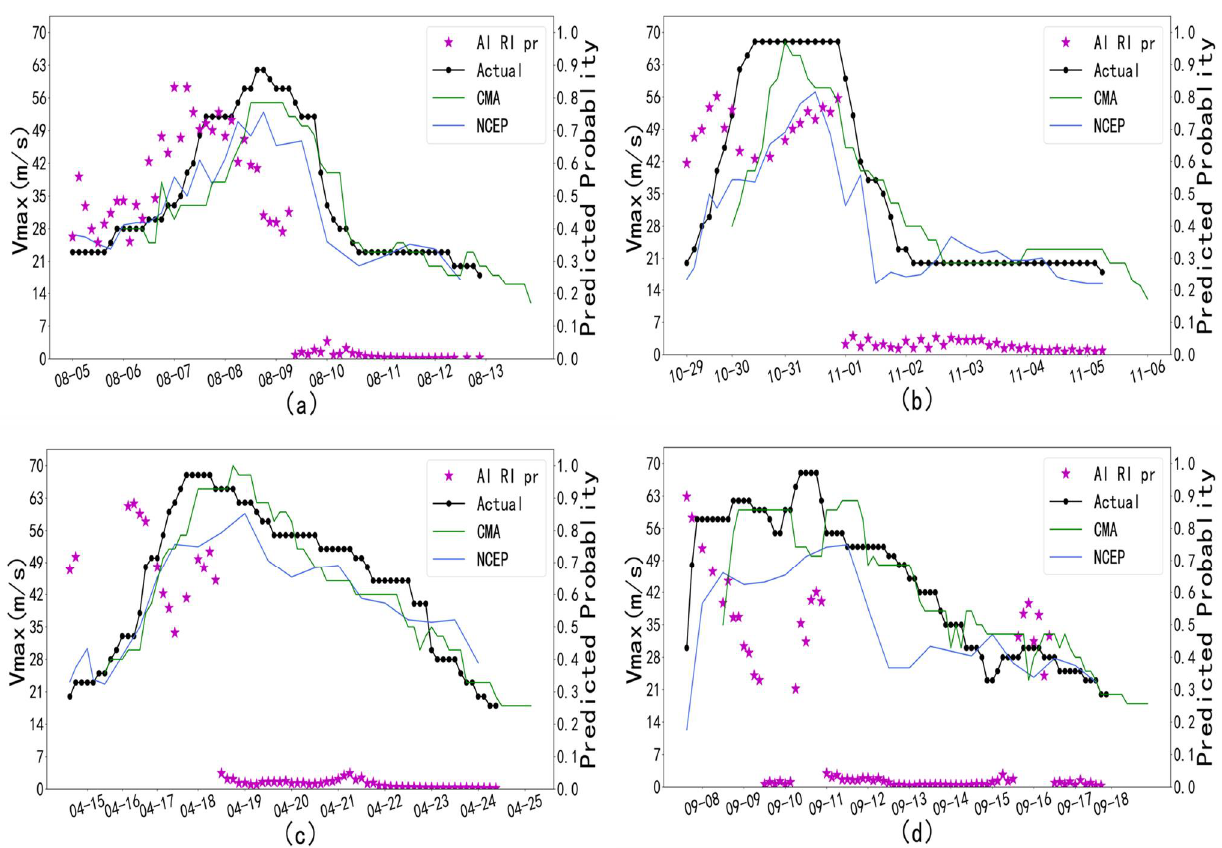
Figure 6. The RI probability predicted by the model (purple asterisk) compared with the actual intensity (black dot line) and the forecast intensity of the NCEP model (blue line) and CMA (green line) for: ( a ) 1909 Typhoon LEKIMA, ( b ) 2019 Typhoon GONI, ( c ) 2102 Typhoon SURIGAE, and ( d ) 2114 Typhoon CHANTHU.